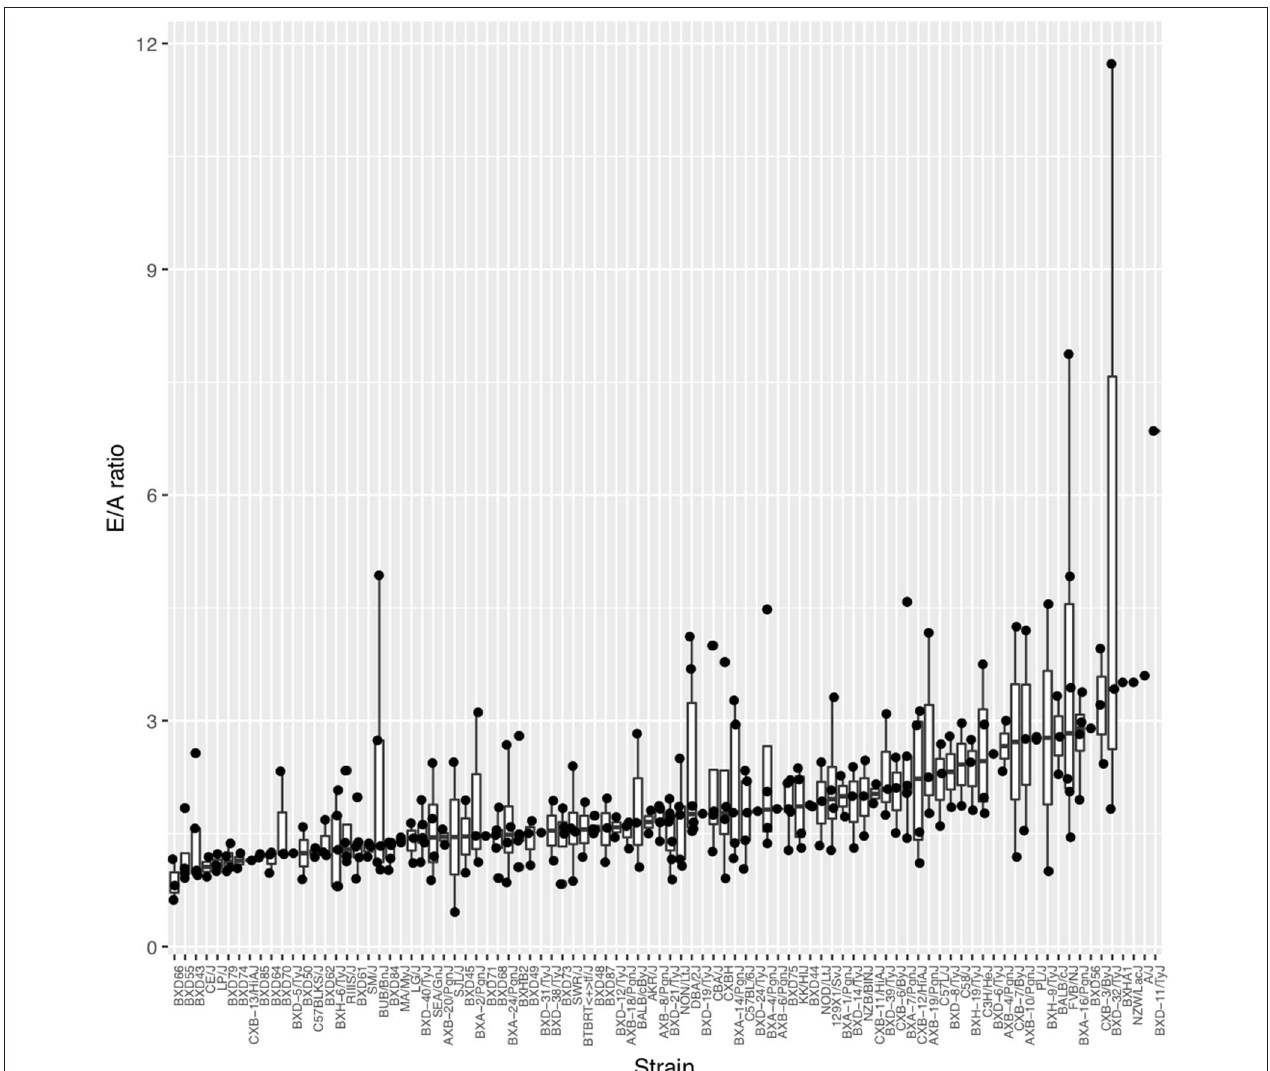
FIGURE 1 | The spectrum of diastolic function as measured by E/A ratio across the Hybrid Mouse Diversity Panel (HMDP) strains. Boxplots represent the intra-strain variation in E/A ratio. Strains are ordered by median E/A ratio.